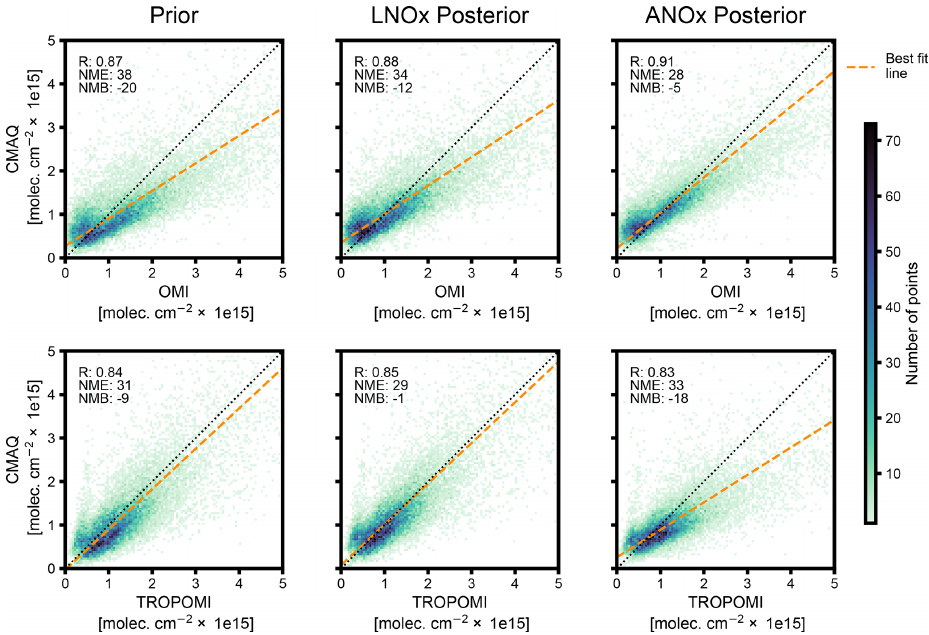
Figure 9. Impact of NO x emissions updates on modeled NO 2 VCDs. Plots compare 2019 season-average CMAQ-modeled NO 2 VCD at each model grid cell in which NO x emissions were updated by the inverse modeling framework against OMI and TROPOMI tropospheric NO 2 VCD retrievals averaged in each model grid cell. Modeled NO 2 VCD using prior emissions (Prior), inferred LNOx emissions (LNOx posterior), and inferred lightning and anthropogenic NO x emissions (ANO x posterior) are each compared with NO 2 VCD retrievals. Top- row plots compare retrievals and modeled VCD based on OMI observations, while bottom-row plots compare retrievals and modeled VCD based on TROPOMI observations. Linear regression line, correlation coefficient ( R ), normalized mean error (NME), and normalized mean bias (NMB), relative to tropospheric NO 2 VCD retrievals, are shown for each CMAQ simulation.